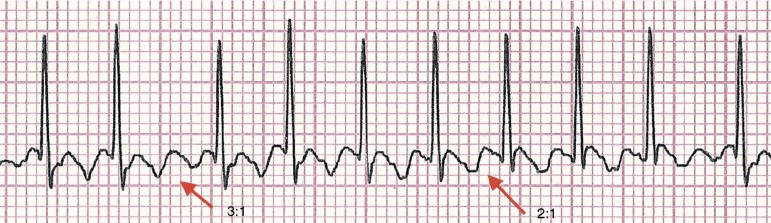
Eletrocardiograma que evidencia o padrão serrilhado do flutter atrial com condução atrioventricular 3:1 e 2:1 na derivação D2.